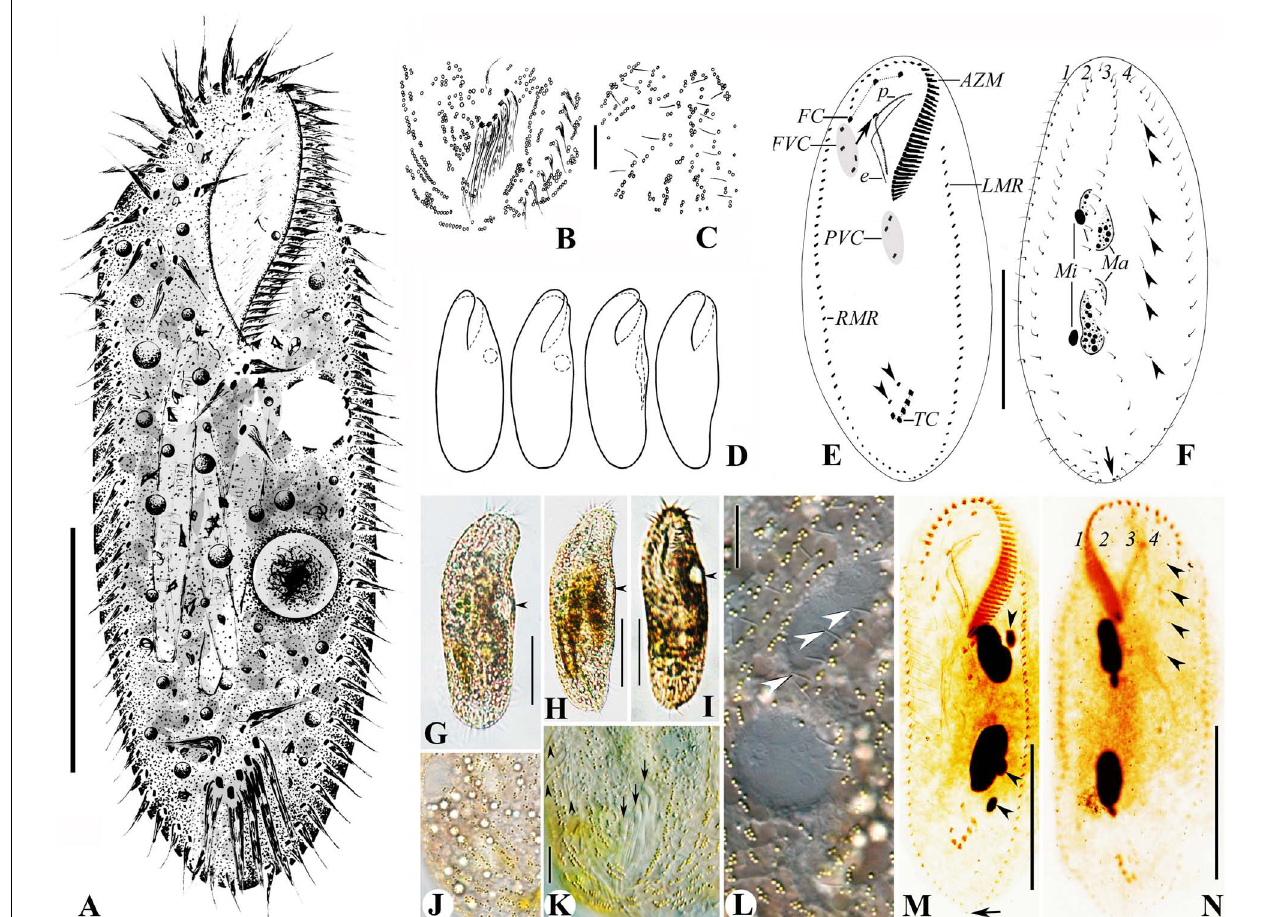
FIGURE 4 | (A–N) Morphology and ciliature of the Wuhan population of Rubrioxytricha haematoplasma from life ( A–D ; G–J , bright field; K,L , differential interference contrast) and after protargol impregnation (E,F,M,N) . (A) Ventral view of a representative individual. (B,C) Distribution of cortical granules on the ventral (B) and dorsal (C) side. (D) Ventral views, showing body shape and contractile vacuole. (E,F) Ventral (E) and dorsal (F) views of a representative specimen, showing ciliature and nuclear apparatus; arrowheads in (E) mark pretransverse ventral cirri; arrow in (E) indicates buccal cirrus; arrowheads in (F) show parental dorsal bristles; arrow in (F) marks the single caudal cirrus at end of dorsal kinety 3. (G–I) Ventral view of representative individuals, showing body shape, flexibility, and contractile vacuole (arrowhead). (J) Dorsal view of a slightly squeezed cell, showing the color of cortical granules and cytoplasm. (K) Ventral view of the posterior part of a slightly squeezed cell, showing the distribution of cortical granules; arrowheads indicate right marginal cirri; arrows show the slightly enlarged transverse cirri. (L) Dorsal view of a slightly squeezed cell, showing the distribution of cortical granules on the dorsal side; arrowheads indicate dorsal bristles. (M,N) Ventral (M) and dorsal (N) views of representative specimens, showing ciliature and nuclear apparatus; arrowheads in (M) show micronuclei; arrow in (M) indicates the single caudal cirrus; arrowheads in (N) mark parental dorsal bristles. AZM, adoral zone of membranelles; e, endoral membrane; FC, frontal cirri; FVC, frontoventral cirri; LMR, left marginal row; Ma, macronuclear nodules; Mi, micronuclei; p, paroral membrane; PVC, postoral ventral cirri; RMR, right marginal row; TC, transverse cirri; 1–4, dorsal kineties. Scale bars = 50 µ m (A,E,F,G–I,M,N) and 10 µ m (B,C,K,L)